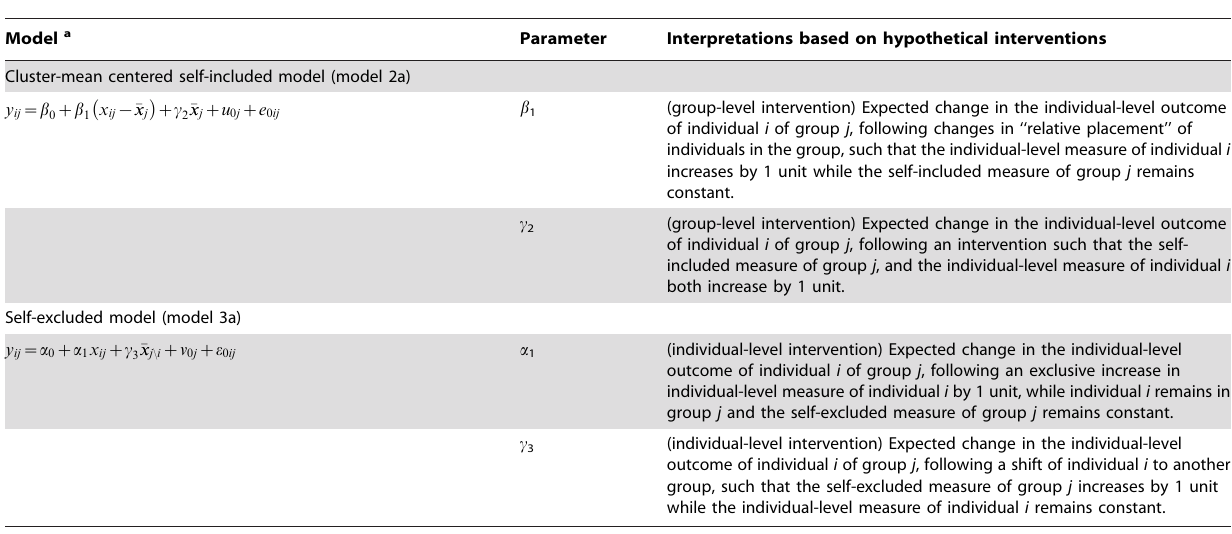
Table 2. Interpretations of parameters in cluster-mean centered self-included model and self-excluded model.